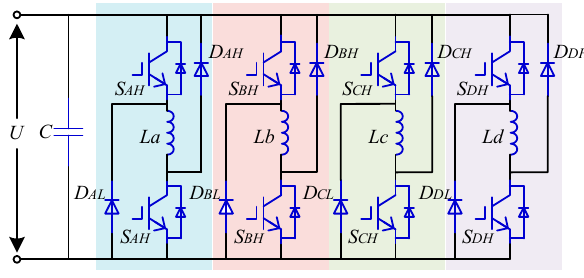
Figure 4. Asymmetric half-bridge converter.